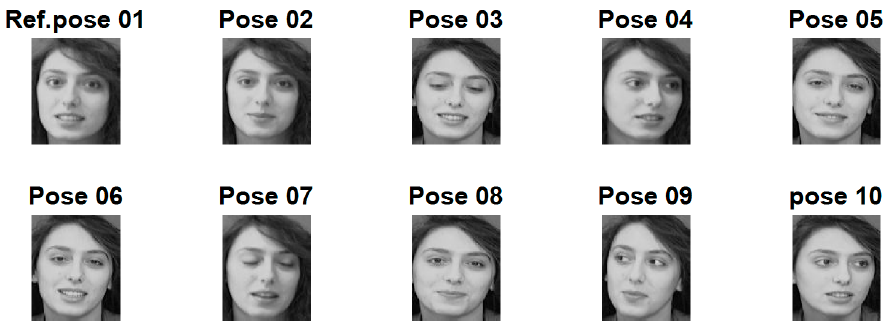
Figure 4. Poses for person No. 8 in AT&T database.